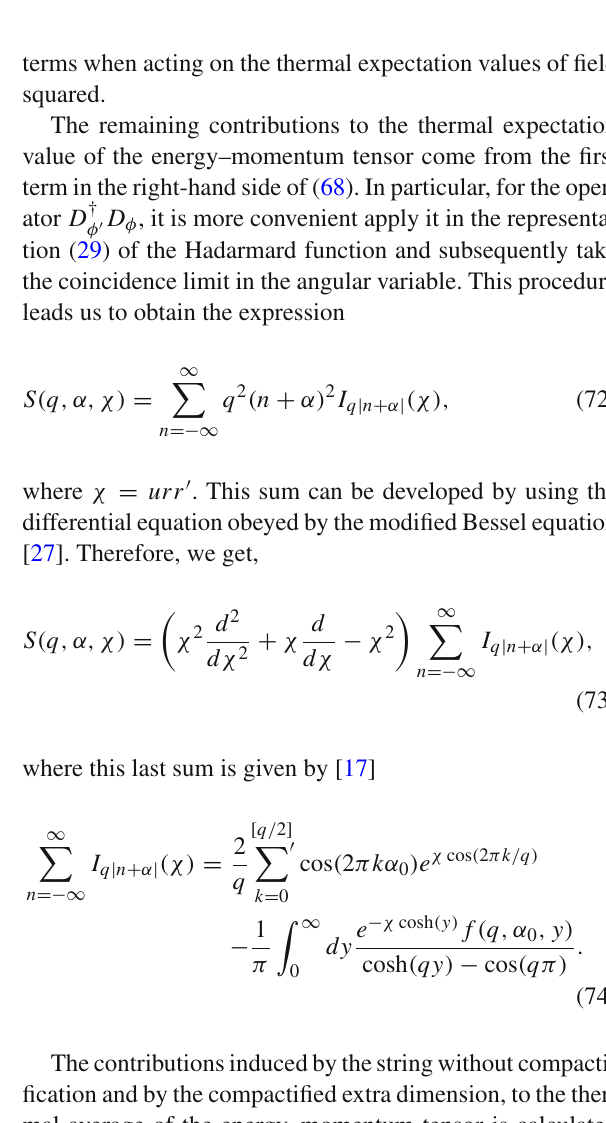
Fig. 2 The thermal field squared induced by the compactification is plotted for D = 3 as functions of the ratios r / L and the T / m , with fixed parameters q = 2 . 5, | ˜ μ | / m = 0 . 5, ˜ η = 0 . 5 and α = 0 . 25. For the left panel we 0 have also fixed mr = 1 and the numbers near the curves correspond to different values of T L . For the right panel we have set mL = 0 . 75 and the numbers near the curves correspond to different values of α 0 Similar to what we have seen in the case of the field squared, the energy–momentum can be also decomposed